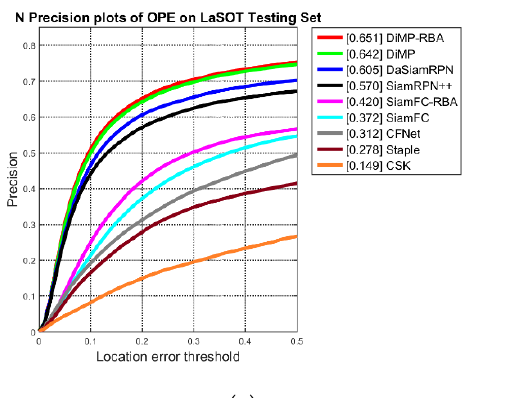
Figure 10. Comparison between the proposed method and baseline trackers on the GOT-10k bench- mark.